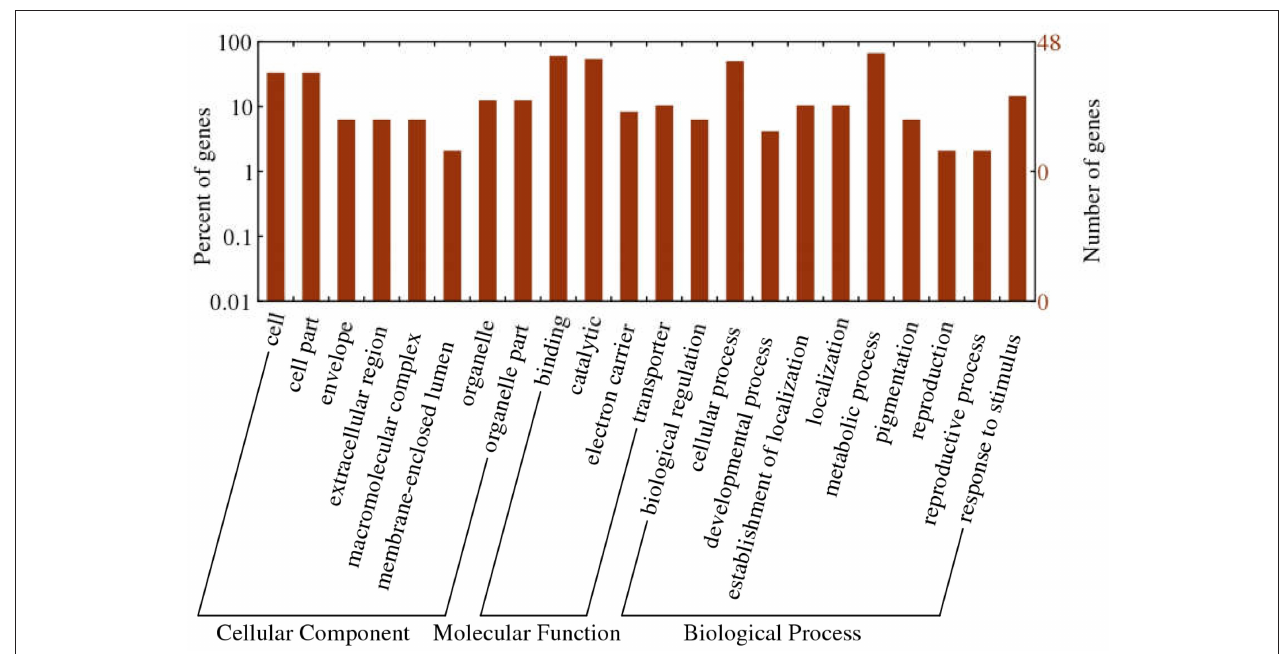
FIGURE 7 | Gene Ontology (GO) categories of common DEGs in SAF-VS-SAP paired